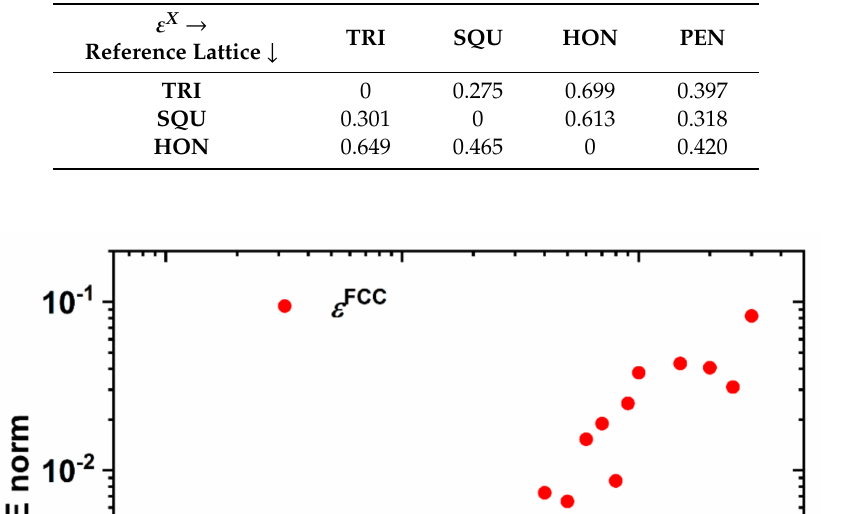
Table 4. Characteristic Crystallographic Element (CCE) norm, ε X , when the analysis is applied on reference 2-D honeycomb (HON), square (SQU) and trigonal (TRI) lattices. Also reported are results from CCE application with respect to the pentagonal local symmetry ( X = PEN).